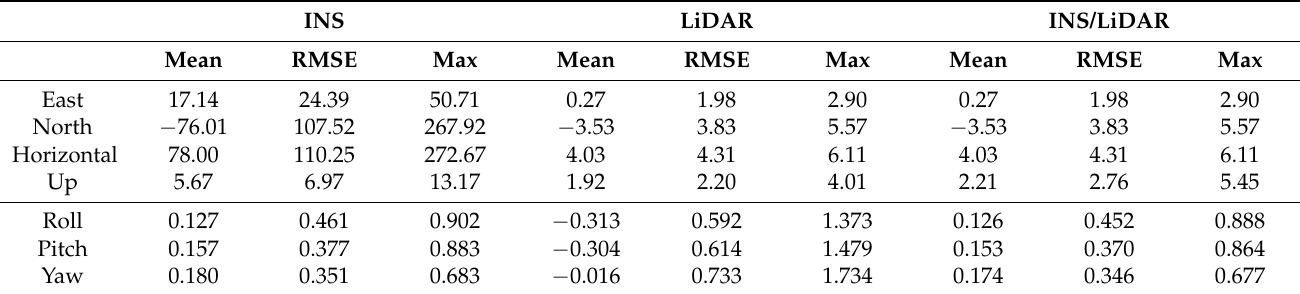
Table A4. D-22—position (m) and attitude (deg) error statistics.